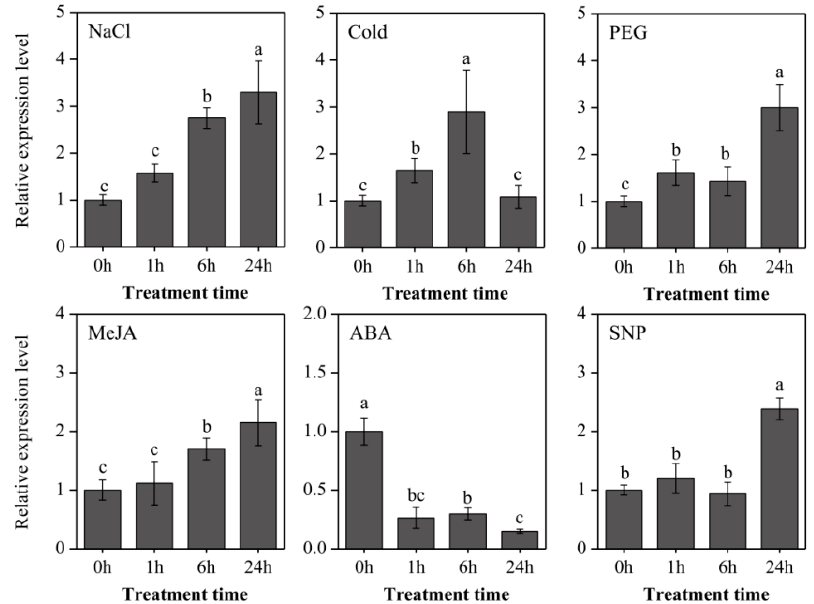
Figure 5. Expression patterns of LaOMT1 during L. aurea roots treated with NaCl, cold, PEG, MeJA, ABA, and SNP. The expression level of LaOMT1 was measured using qRT-PCR analysis, and normalized to the reference gene LaTIP41 . The expression of LaOMT1 in control sample (without treatment at 0 h) was defined as 1.0. Values were shown as means ± standard deviation (SD) of three independent biological replicates. Different letters above the bars indicate that the means are statistically different according to Duncan’s multiple test ( p < 0.05). NaCl, sodium chloridel; PEG, polyethylene glycol; MeJA, methyl jasmonate; ABA, abscisic acid; SNP, sodium nitroprusside.